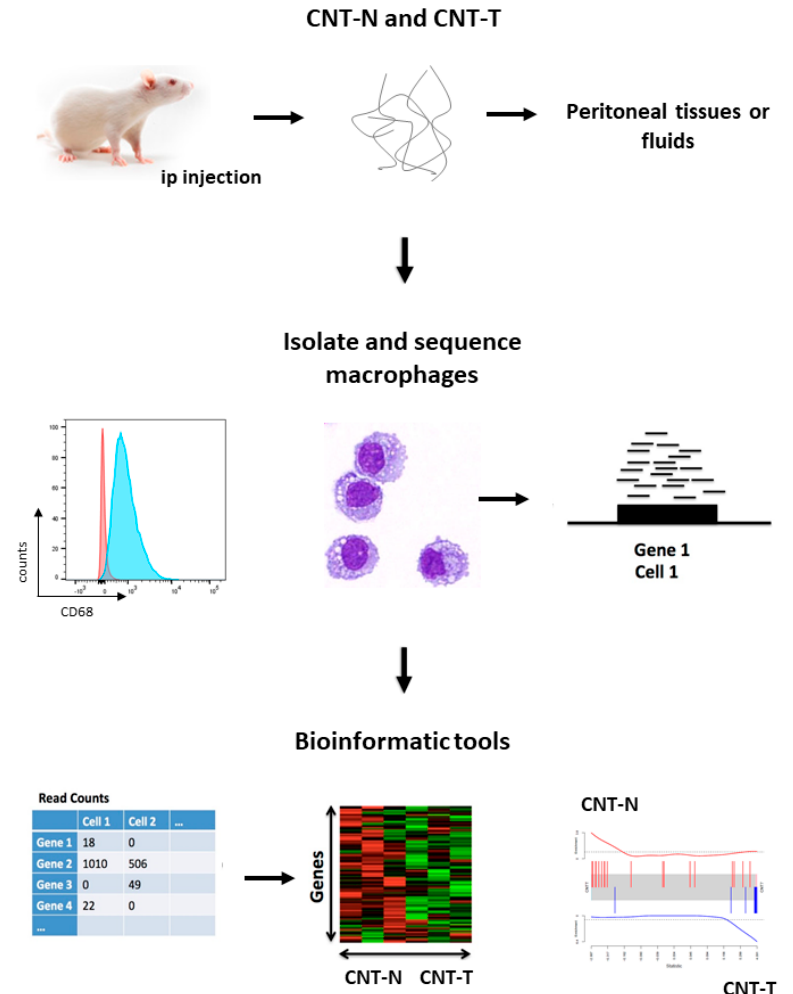
Figure 4. New opportunities to use CNT for delineating specific macrophage immune pathways specifically associated with malignant mesothelioma. Cellular and molecular characterization of macrophage subpopulations by using next-generation sequencing (NGS) technologies. Peritoneal macrophages from CNT-N or CNT-T-treated rats (day 15) were isolated from peritoneal cell suspensions using flow cytometry cell sorting (FACSAria III, BD Biosciences) and APC-antibodies specific for CD68 (mouse anti-rat CD68 antibody, Abcam monoclonal). Cytocentrifuge preparations of purified macrophages were stained with Di ff -Quick. RNA was isolated using Qiagen kits and libraries were prepared and sequenced using the Illumina platform. The gene count matrix was transformed in fold-change-related tables or barcode